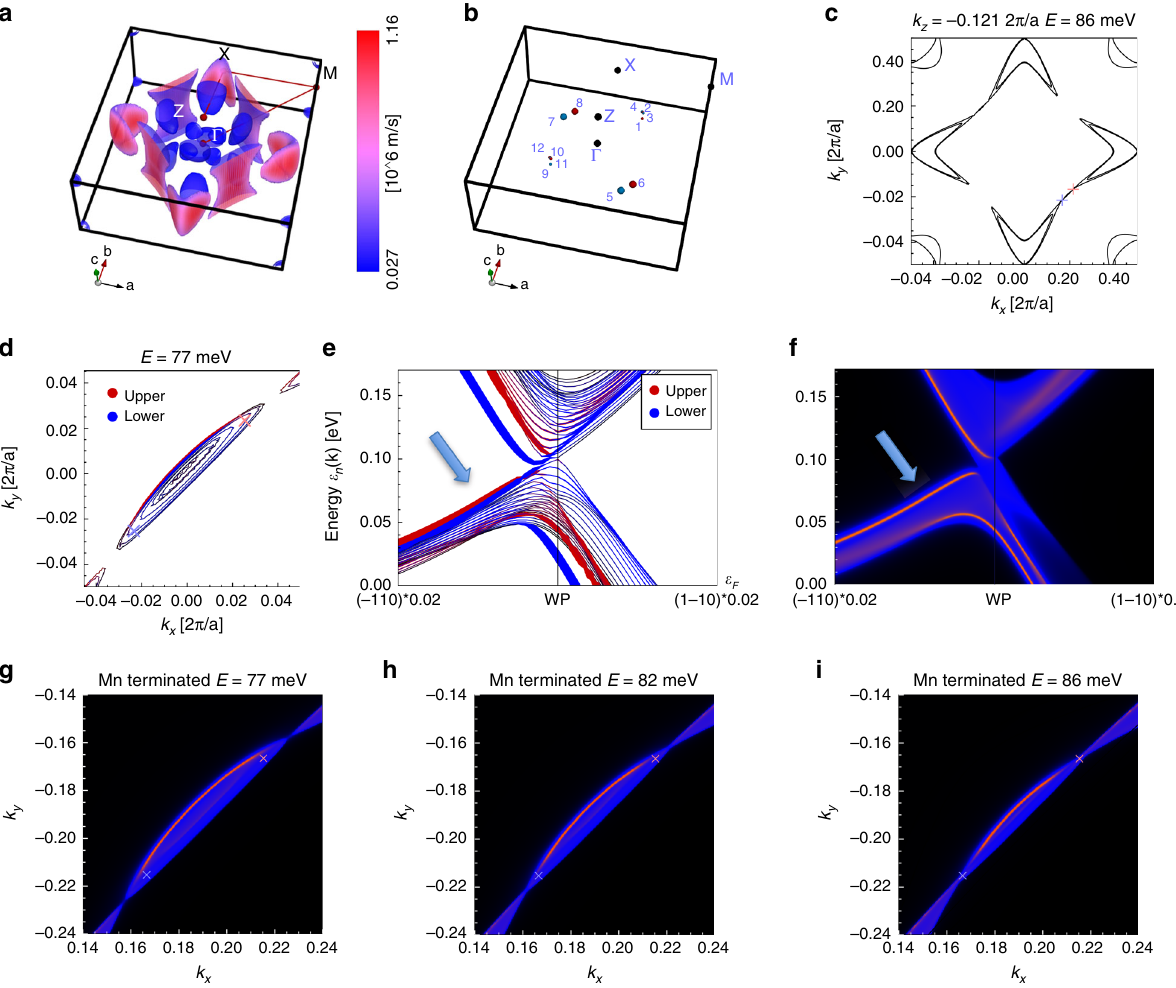
Fig. 4 Calculated Fermi surface arcs (FPLO). a Three-dimensional representation of the Fermi surface of YbMnBi 2 without canting. Colors correspond to Fermi velocities. Blue Fermi surfaces in the middle of the BZ are highly 3D and are occasionally seen in different experimental FS maps as diffused intensity, e.g., Figure 3a and Supplementary Fig. 8. b Location of all Weyl points in the BZ for the case of 10° canting. The color of the WPs indicates the chirality. c FS contour for the k z corresponding to Weyl points #5 and #6, which are shown as small crosses in the places where the lens connects to the electron pocket. d FS contours of the bulk bands and arcs corresponding to the upper (red) and lower (blue) surfaces obtained in 14-unit-cell-slab calculations, at 77 meV (slightly below the WP energy). e Results of the same calculations as in ( d ) for the dispersion along a line perpendicular to the lens, cutting it at the midpoint between WPs #5 and #6. The arrow points to the closely separated topological surfaces states supporting the similar arcs on both surfaces. f Spectral function calculated along the same line as for ( e ) for a semi-in fi nite-slab in the limit of extreme surface sensitivity (12 a B penetration depth). A topological surface state is clearly visible as sharp red feature on the blue background of the bulk continuum. g – i Spectral function in momentum coordinates for different energies below and including the energy of the Weyl points #5 and #6. The Fermi arc is clearly seen as sharp red feature on